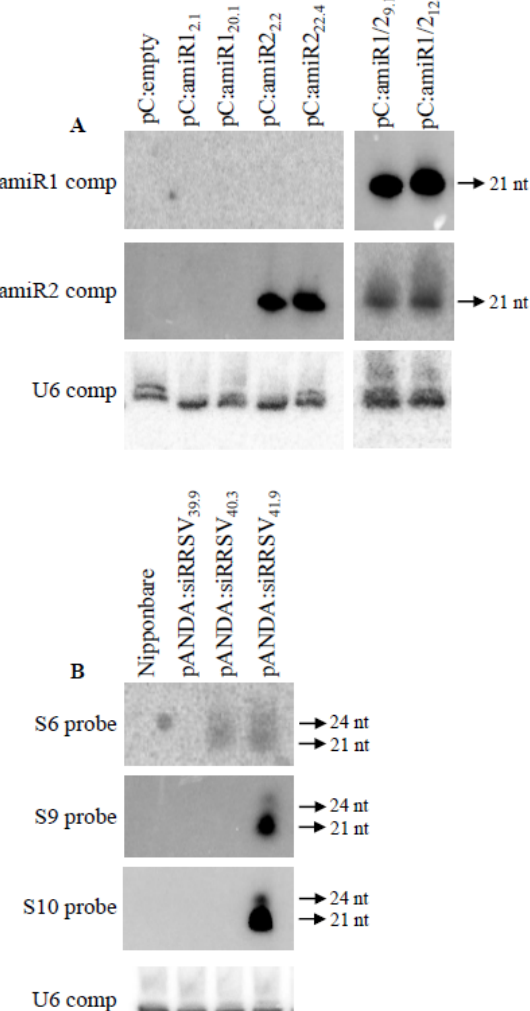
Figure 5. Northern blot detecting amiR ( A ) and siRNA ( B ) accumulation in selected homozygous transgenic lines. Total RNA was extracted from three-week-old rice leaves. ( A ) amiR accumulation was detected by hybridization with the amiR1 or amiR2 complementary sequences as probes (amiR1 comp and amiR2 comp). A transgenic line transformed with an empty construct was used as a negative control (pC:empty). ( B ) siRNA accumulation was detected by hybridization with PCR fragments corresponding to the RRSVs6gp1 fragment (S6 probe), the RRSVs9gp1 fragment (S9 probe), and the RRSVs10gp1 fragment (S10 probe). A non-transformed Nipponbare line was used as a negative control (Nipponbare). For both blots, a U6 hybridization with the U6 complementary probe (U6 comp) was used as an equal loading control. The sizes of the detected bands are indicated. siRNA accumulation corresponding to each of the three segments of the multiple siRNA construct was evaluated by independent hybridizations with three probes, namely the S6, S9, and S10 probes, covering the three segments (Figure 5B). As expected, no signal was detected in the negative control corresponding to the Nipponbare non-transformed